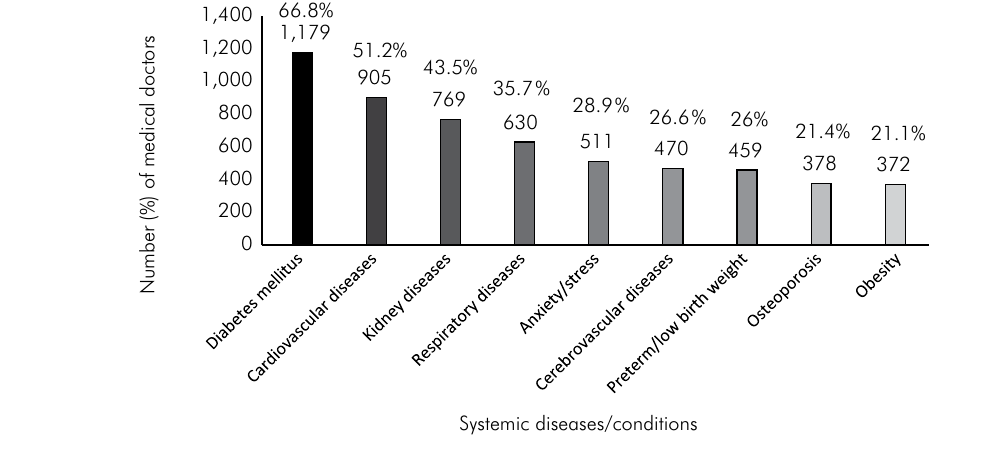
Figure 3. Knowledge of participants about the relationship between PD and systemic diseases/conditions.